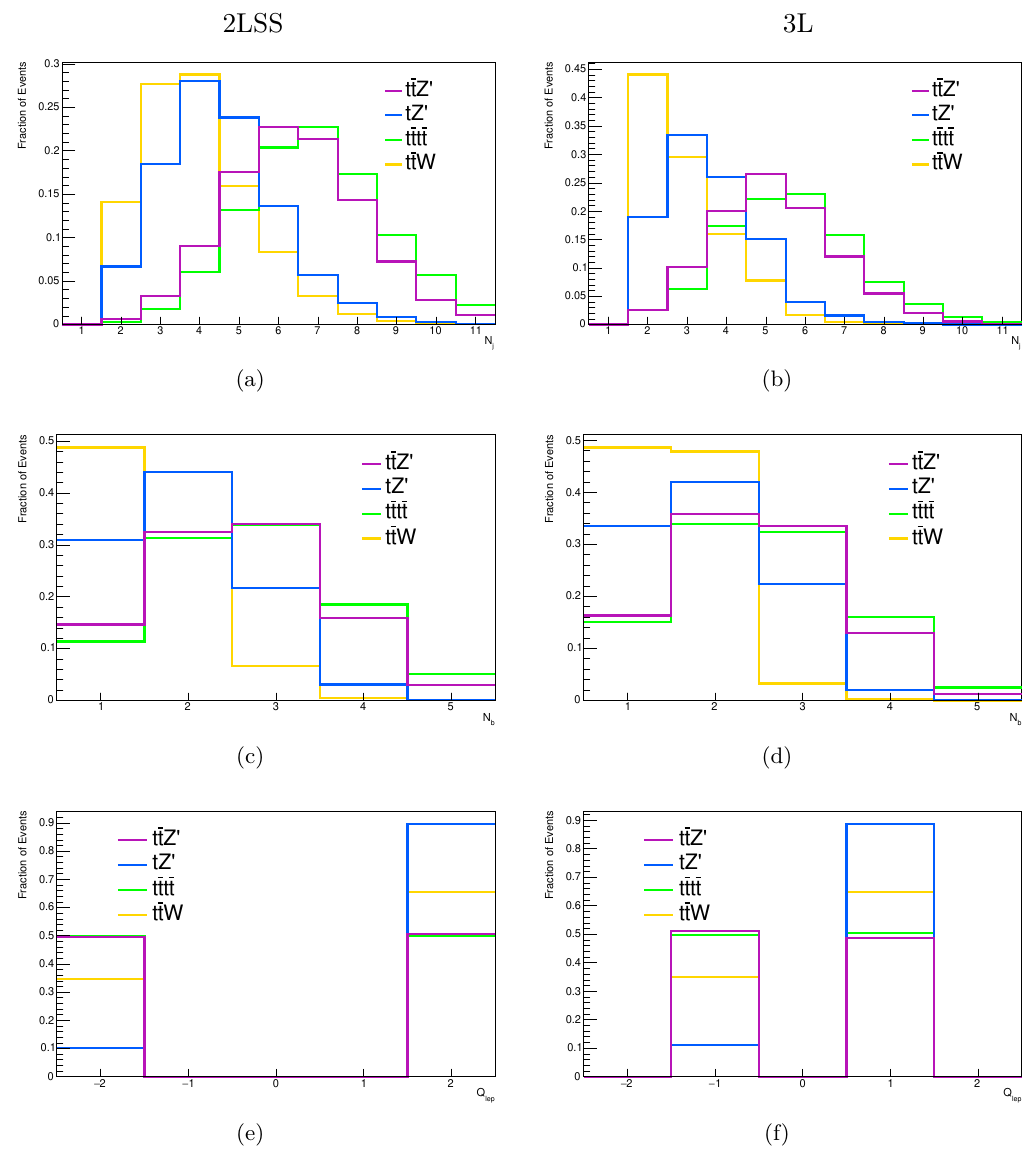
Figure 7 . N j , N b , and Q lep distributions for the 2LSS (left) and 3L (right) categories used for the global analysis. Observe how tZ 0 mimics t ¯ tW and t ¯ tZ 0 mimics t ¯ tt ¯ t , particularly in the N